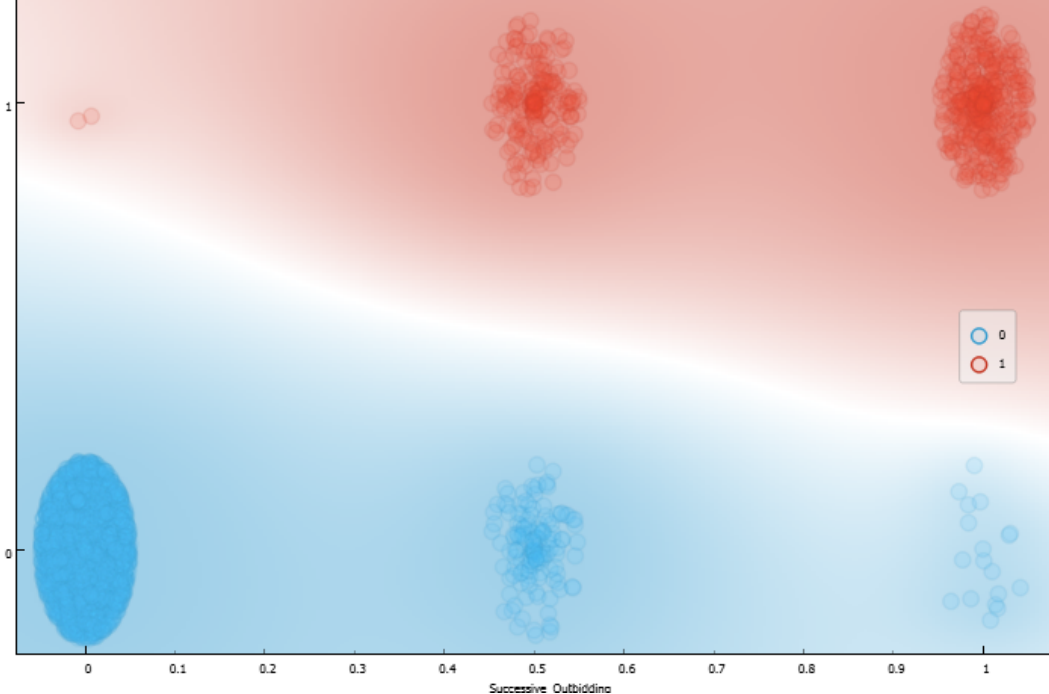
Figure 14. Scatter plot of successive outbidding